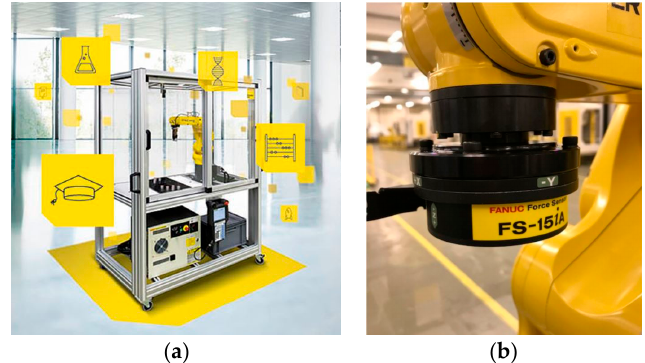
Figure 7. Robotic facility used for the automated test at FANUC Luxembourg, located in Echternach: ( a ) the FANUC Educational Package equipped with the 6-Axis Mechanical Robot LR-Mate 200iD/4S and ( b ) the auto-calibrating Force Sensor FS-15iA mounted on the robot of the facility.